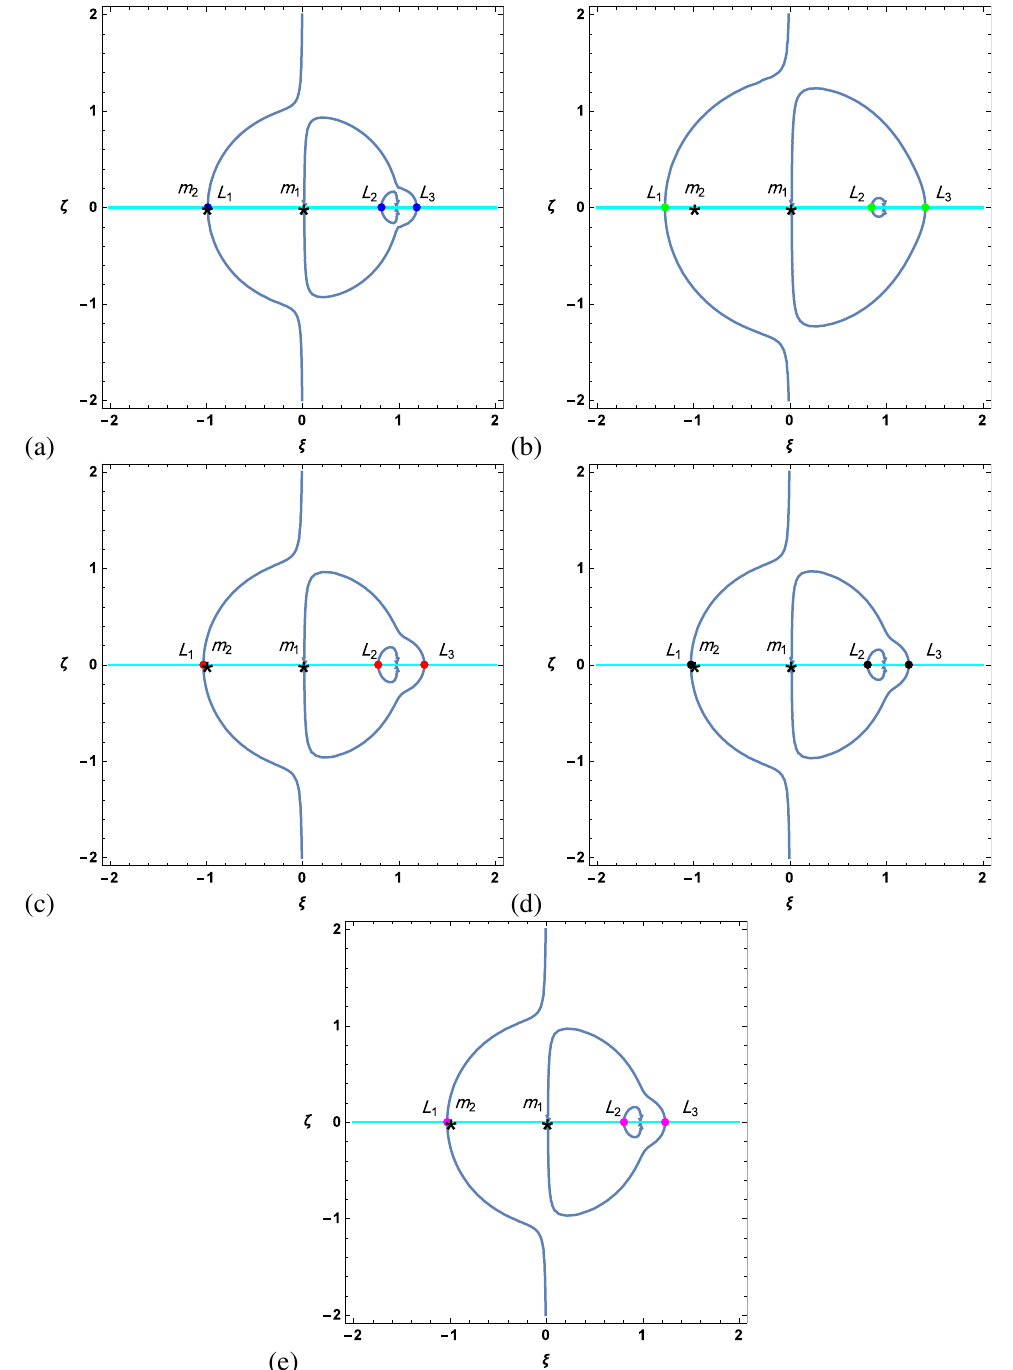
Fig. 3 The locations of lagrangian points during out of plane motion (i.e. ξ (cid:54) = 0 , η = 0 , ζ (cid:54) = 0 ) in five cases: (a). Third primary is placed at one of the lagrangian points of the classical circular restricted three-body problem (points with blue color), (b). Variation of masses (points with green color), (c). Solar radiation pressure (points with red color), (d). Albedo effect (points with black color), (e). Oblateness effect (points with magenta